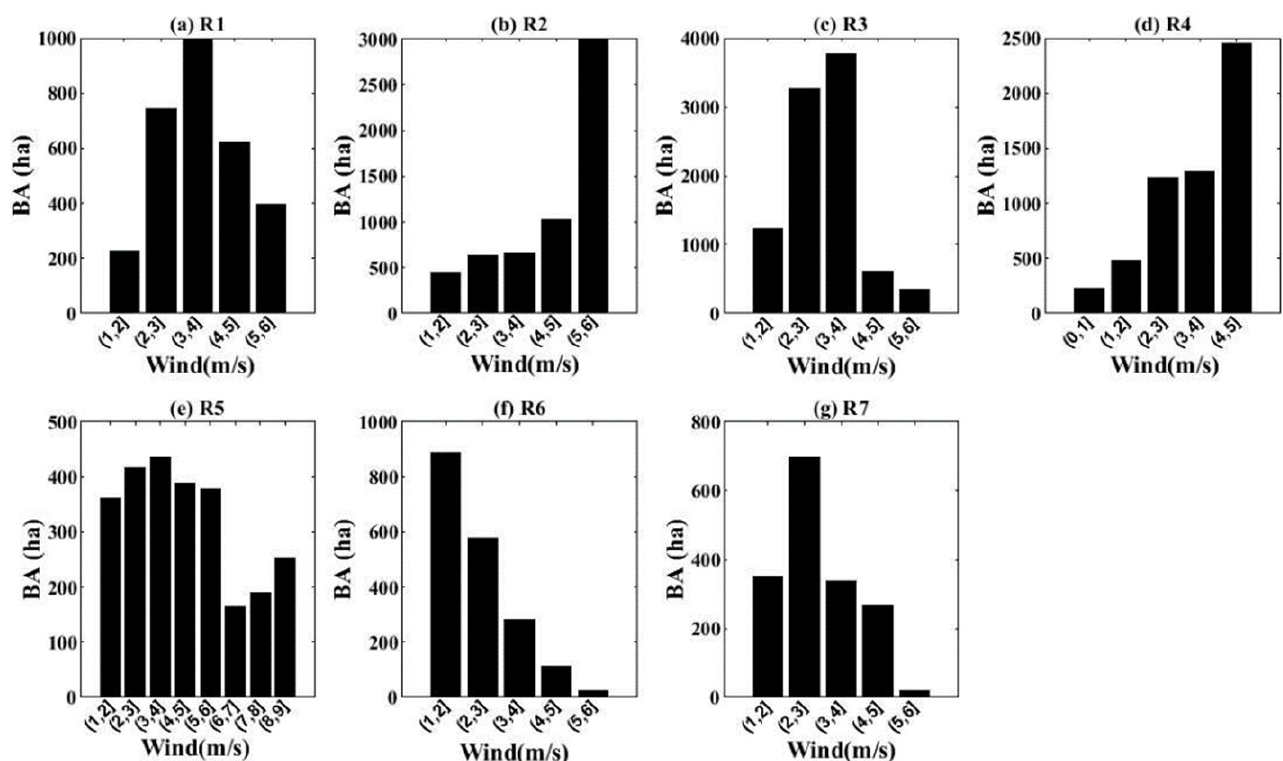
Figure 20. The histogram of BA with different wind speed intervals for ( a – g ) representing R1–R7, respectively.